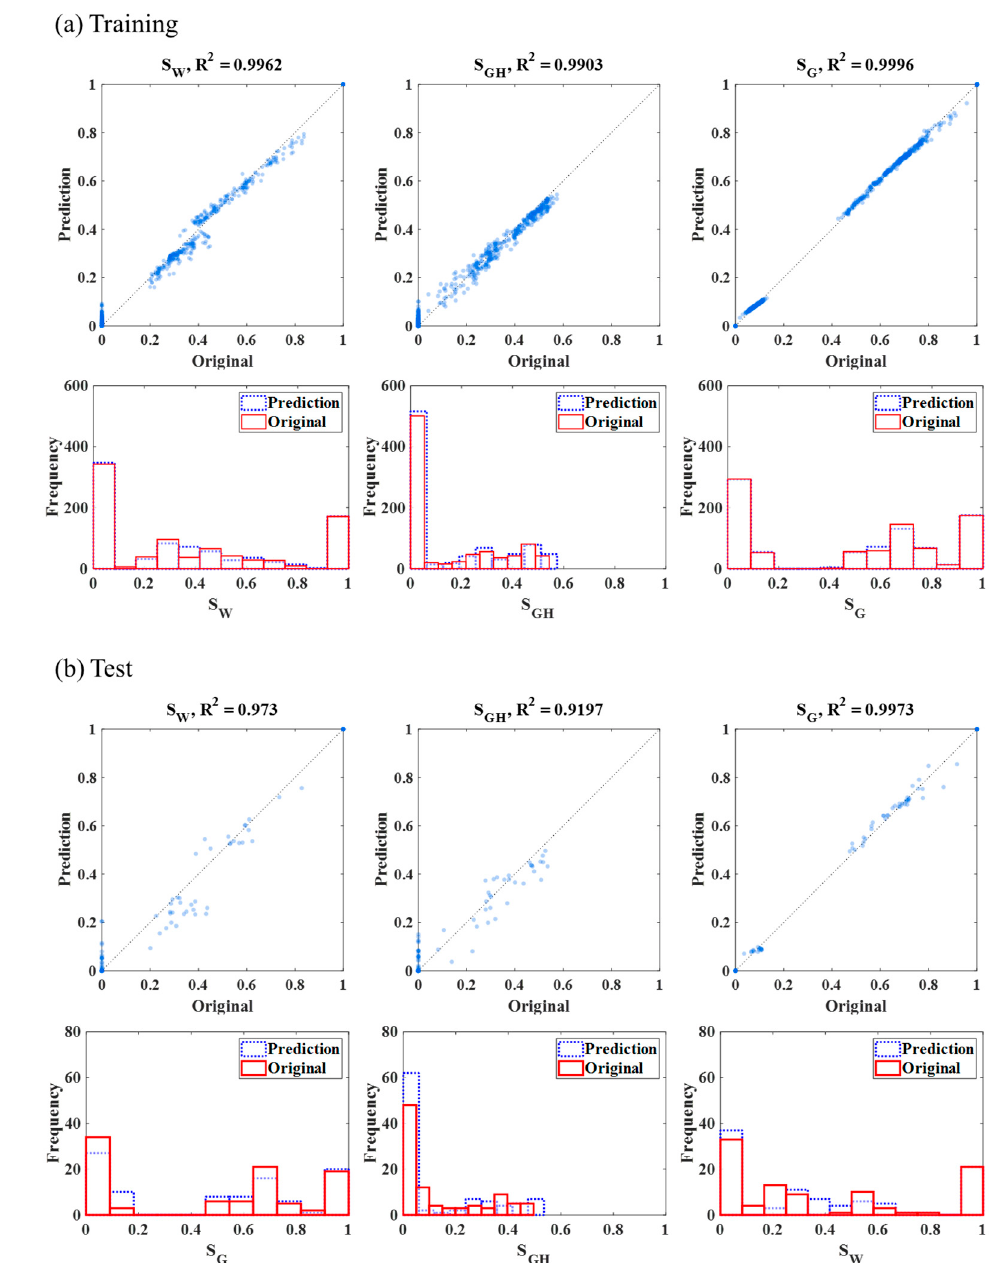
Figure 10. ( a ) Training and ( b ) test results of Case 2, each column means each saturation, water, gas hydrate, and gas with coefficient of determination. In the scatter plots, the X and Y axes indicate the given original data and the predicted value by random forest, respectively. In the histogram pictures, the X and Y axes mean each saturation and frequency, respectively.